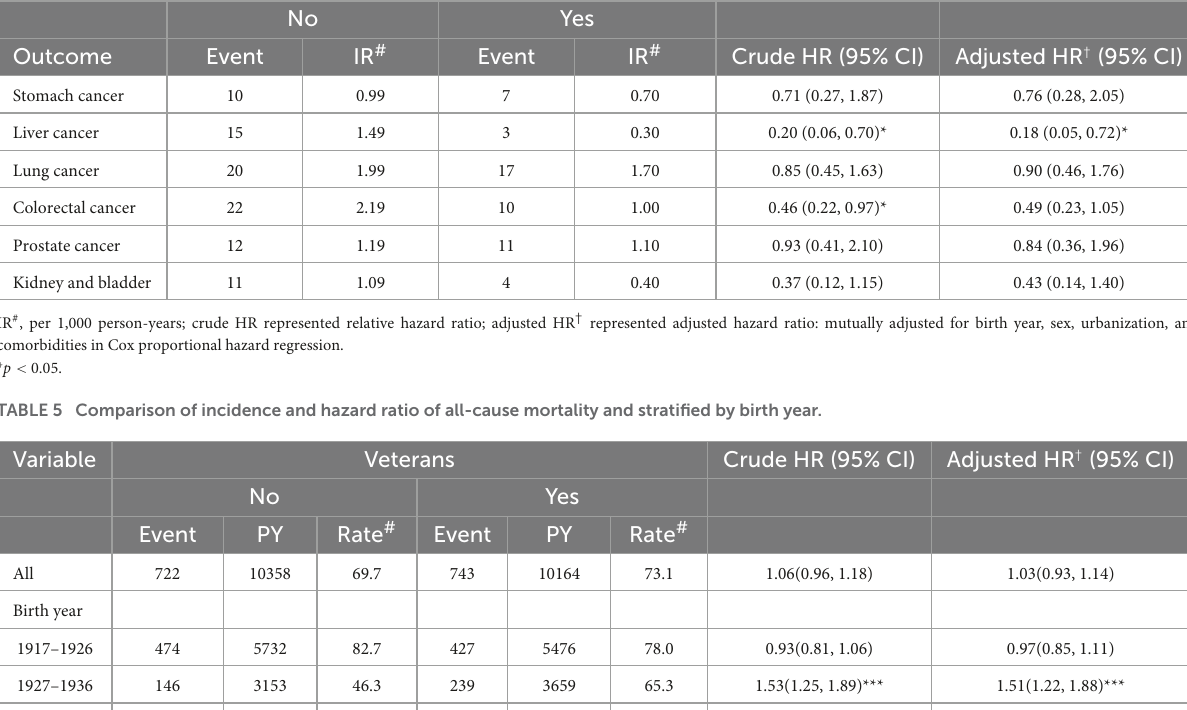
Outcome Stomach cancer